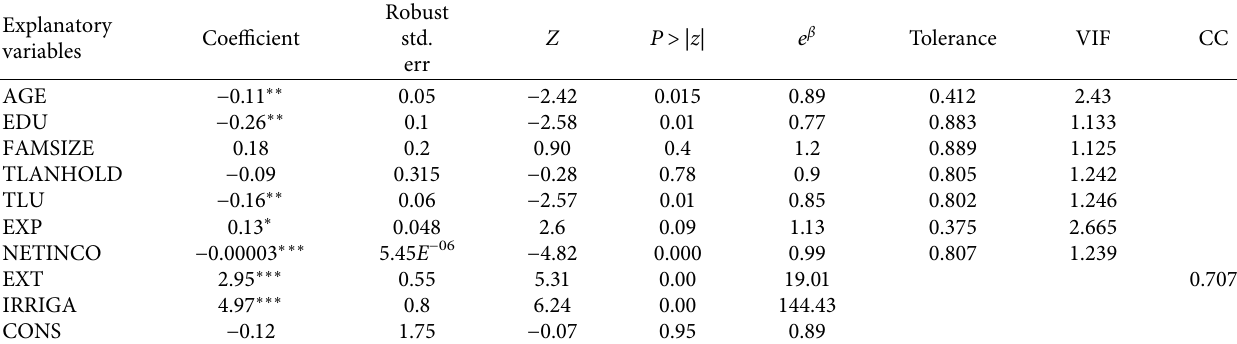
Table 3: Maximum likelihood estimate of the binary logit model for decisions to practice